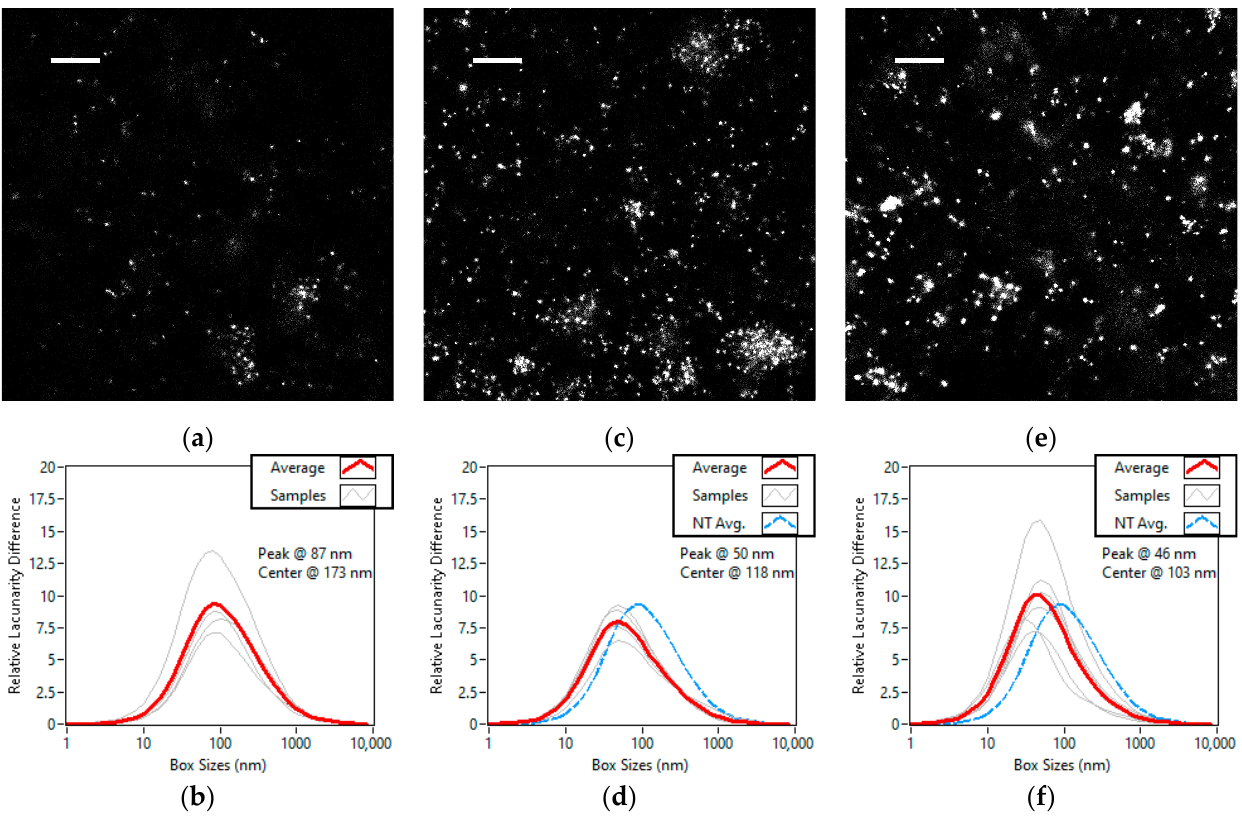
Figure 7. Super-resolution images and lacunarity difference curves of A647 labelled γ H2AX in the nuclei of U2OS and DIvA cells grouped by treatment. Untreated U2OS ( a , b ), NCS treated U2OS ( c , d ) and 4-OHT treated DIvA ( e , f ) cells. Scale bars are 1 µm. The number of studied cells is four, five, and six, respectively. On each lacunarity difference curve, the average of the curves for each cell is shown in red and the average of the untreated U2OS is shown in dashed blue.